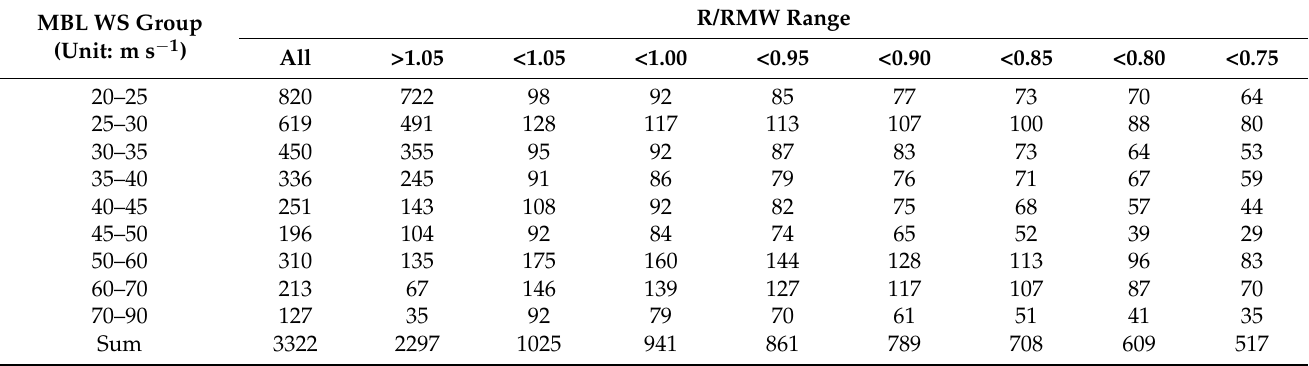
Figure 1. The profile number in each 5 m s − 1 MBL mean wind speed bin. Table 1. The profile number in each MBL mean wind speed group for different R/RMW ranges.